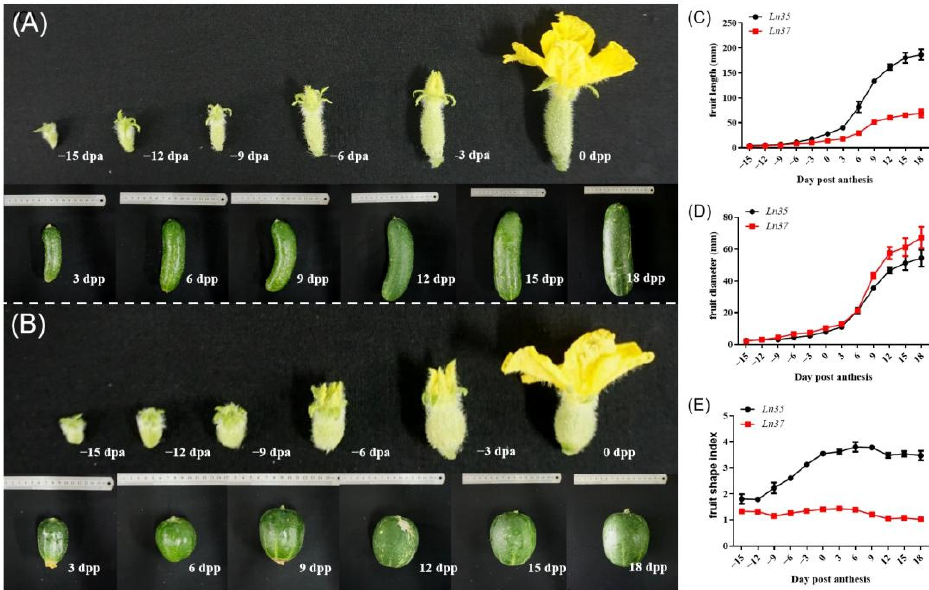
Figure 2. Changes of fruit shape during fruit development in two NILs lines. ( A , B ) is the dynamic changes of fruit in Ln35 and Ln37 , respectively. ( C – E ) was the dynamic changes in fruit length, fruit diameter and fruit shape index in the two